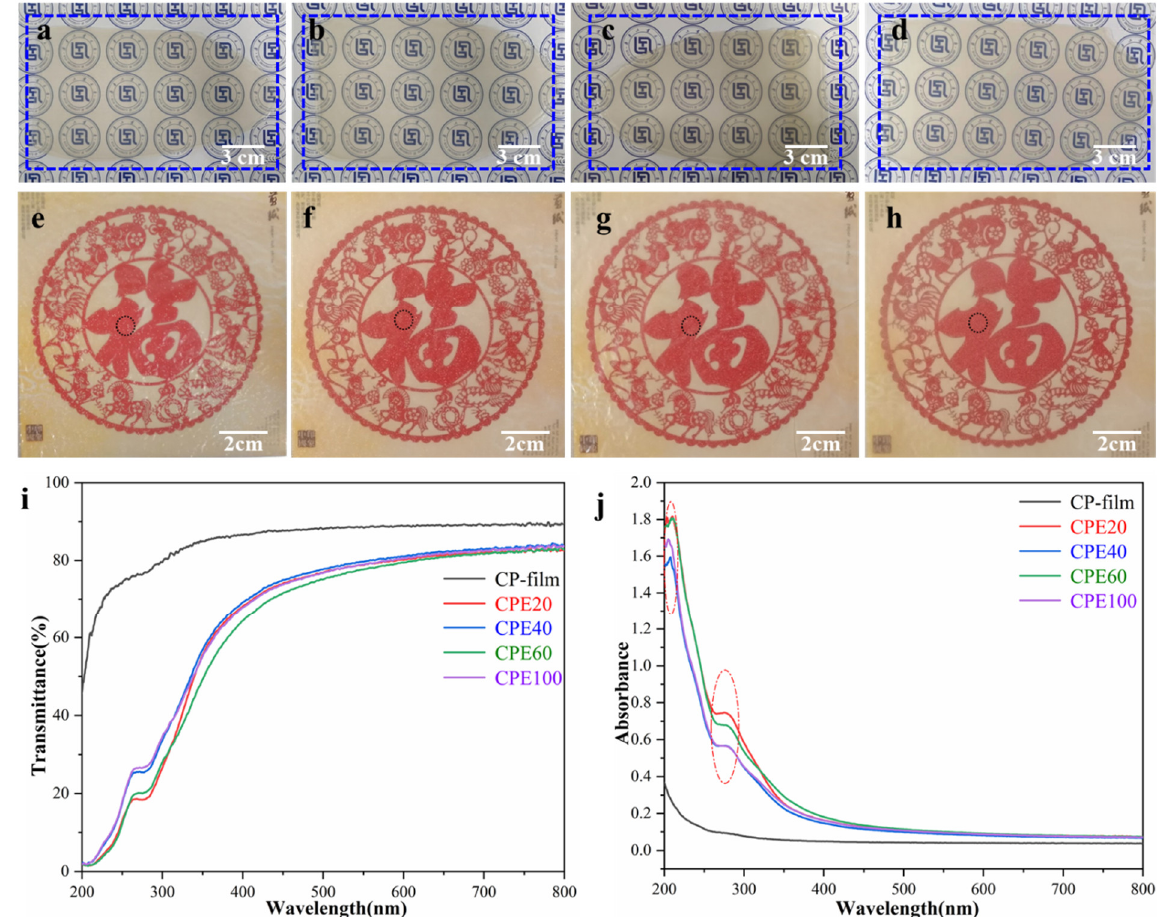
Figure 3. Digital pictures of the cellulose/PE composite gels ( a ), Gel-CPE20; ( b ), Gel-CPE40; ( c ), Gel-CPE60; ( d ), Gel-CPE100) and films ( e ), CPE20; ( f ), CPE40; ( e , g ), CPE60; ( h ), CPE100); UV-Vis spectra ( i – j ) of CP-film and cellulose/PE composite films.